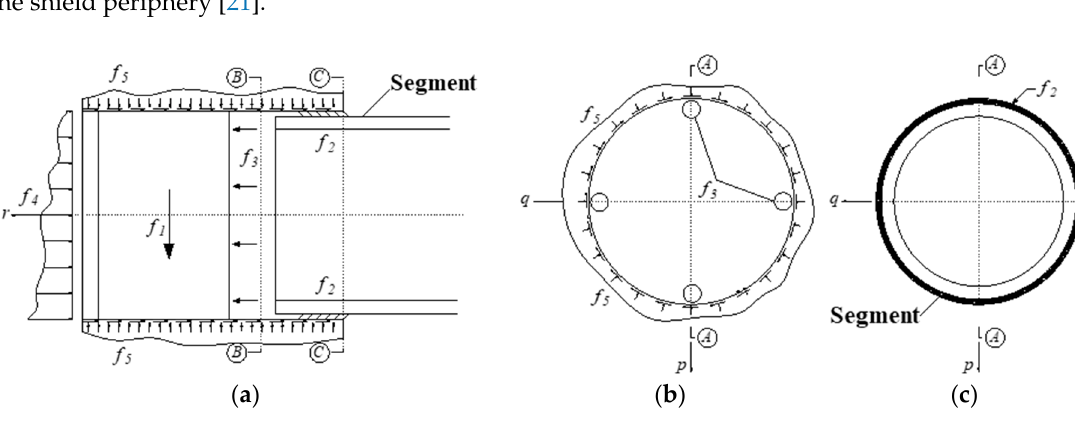
Figure 1. Shield load model: ( a ) Section A-A; ( b ) Section B-B; and ( c ) Section C-C.